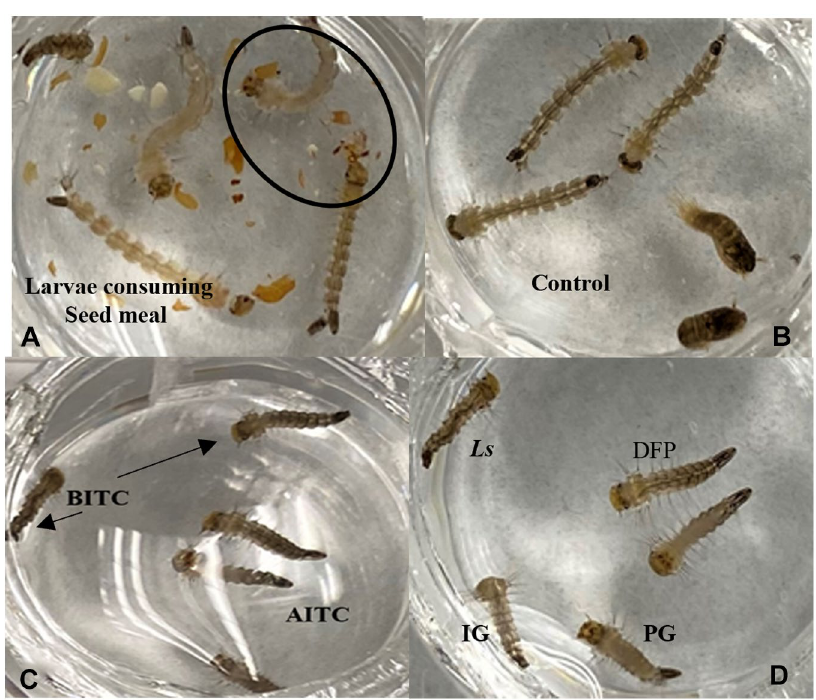
Table 5. Computed amount of isothiocyanates (ppm) for the LC 50 concentrations of seed meal when applied for control of Ae. aegypti larvae and evaluated at 24-h and 74-h continuous exposure. DFP Thlaspi arvense , IG Sinapis alba (Ida Gold), PG Brassica juncea (Pacific Gold), Ls Lepidium sativum .